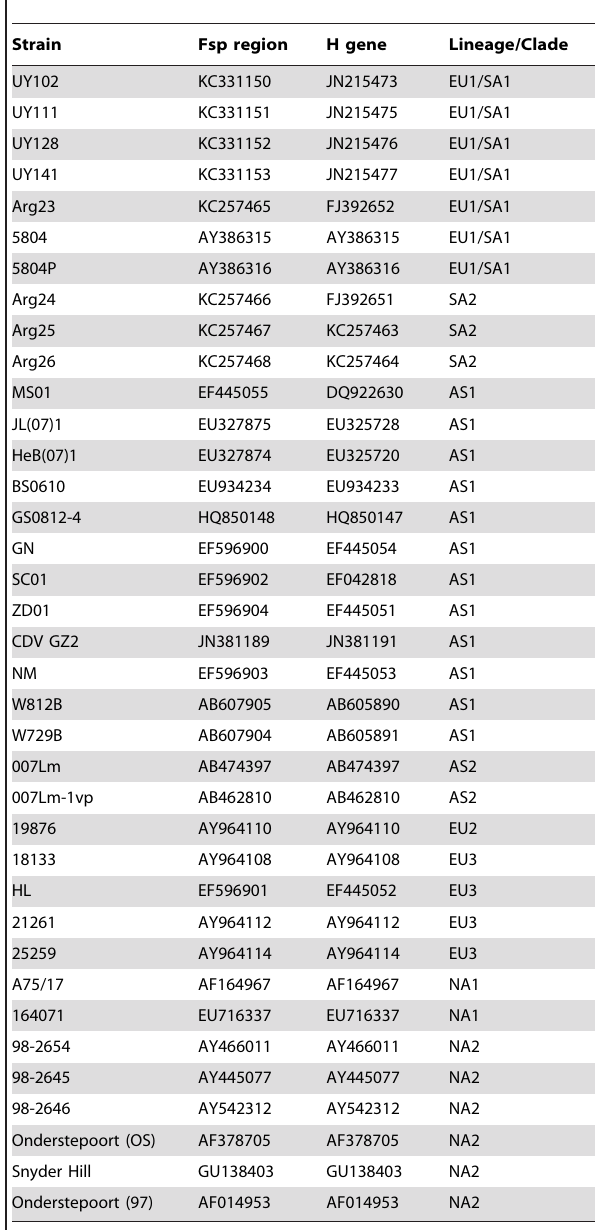
Table 1. Strains employed for the construction of the Fsp and H